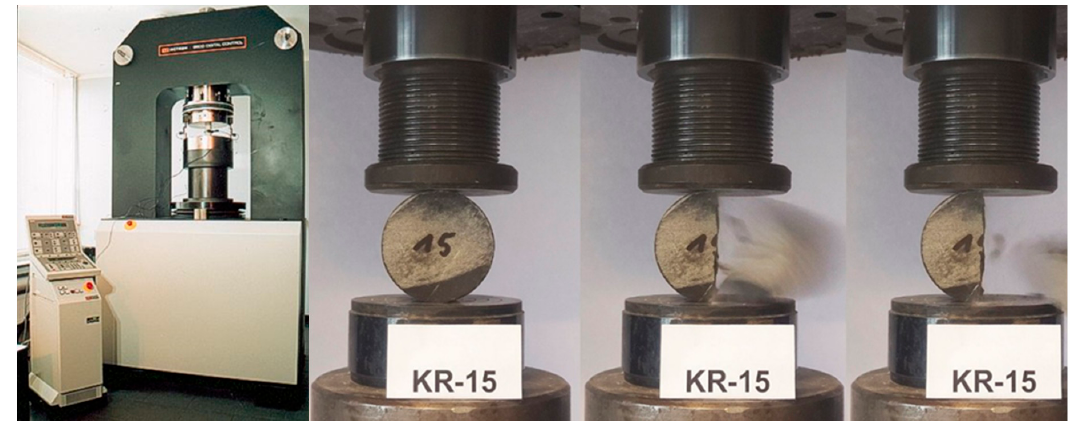
Figure 4. Strength testing machine “Instron” and dolomite sample “KR-15” in a Brazilian test.